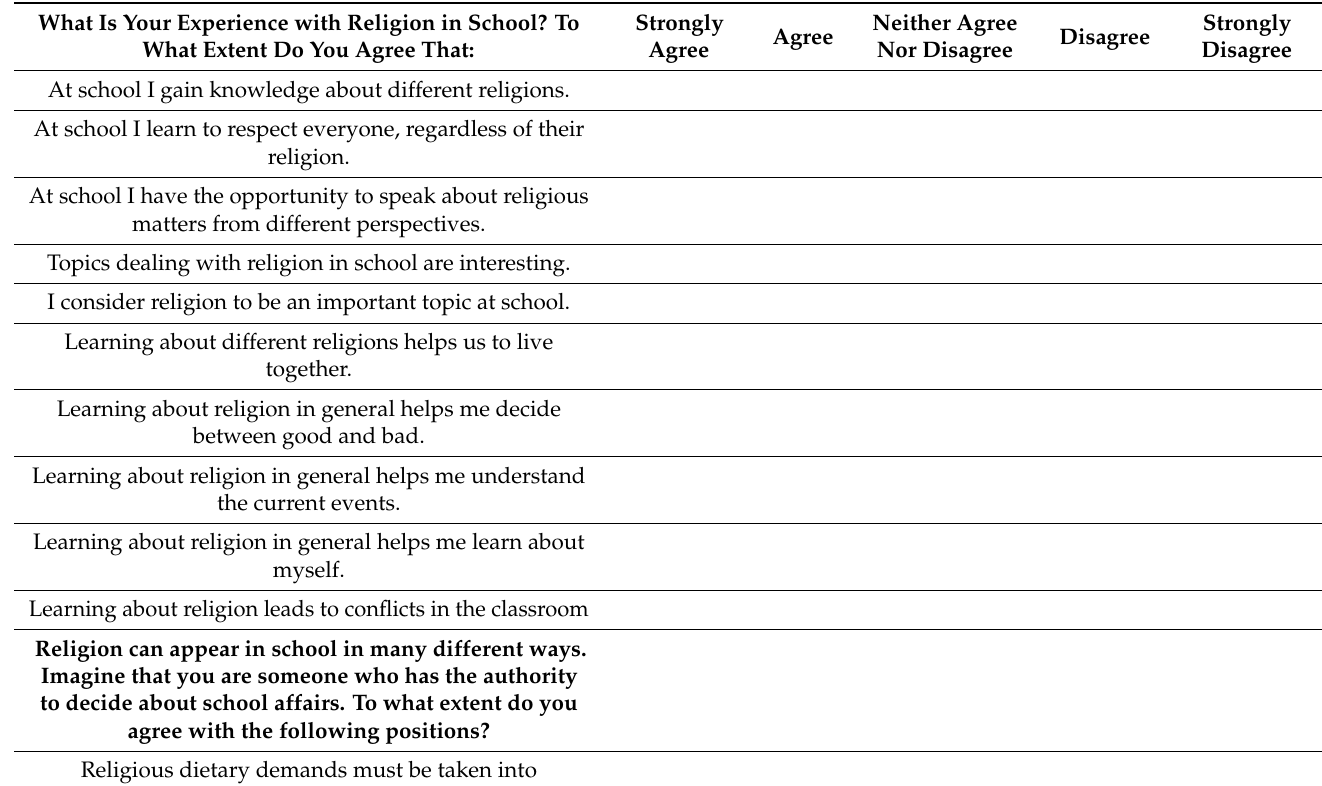
Strongly Neither Agree Disagree Agree Nor Disagree Agree